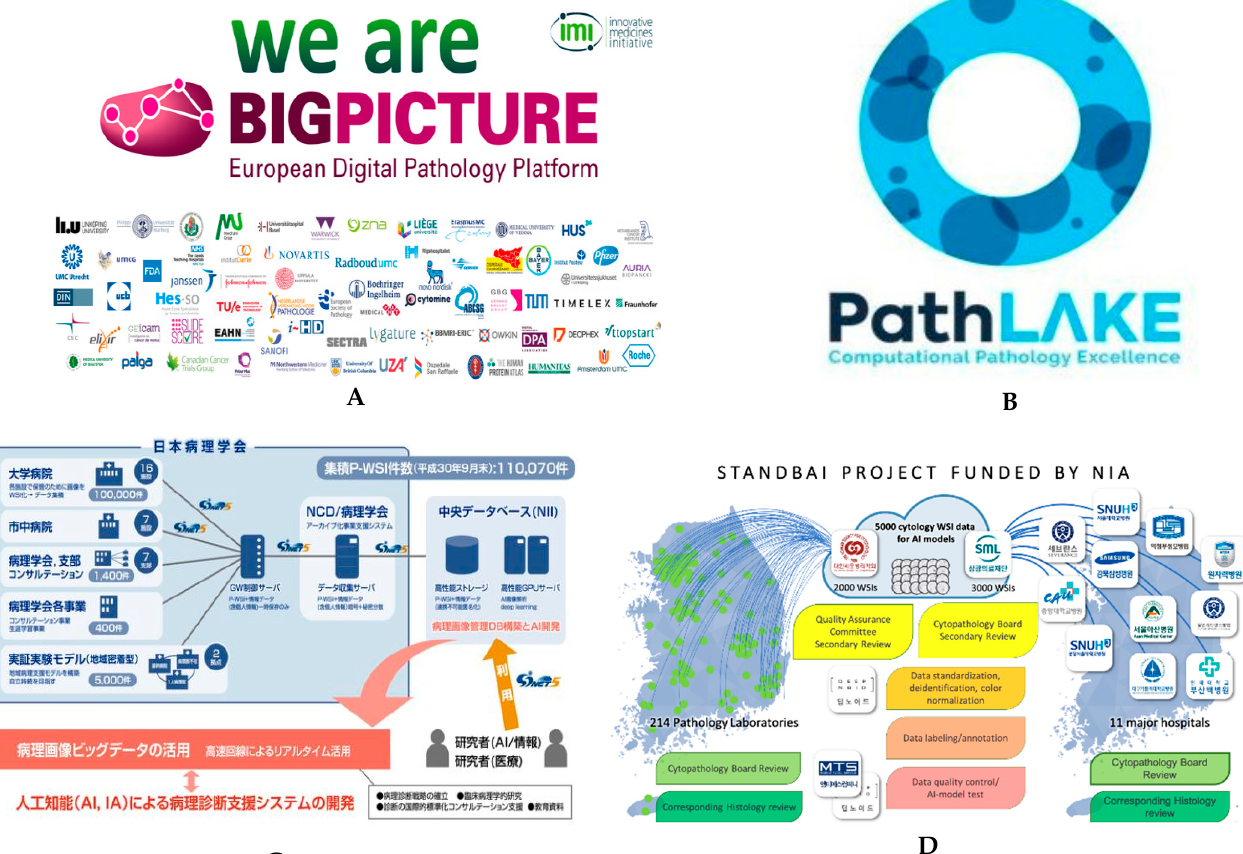
Figure 11. Representative figures of digital slides from repository projects: ( A ) BIG PICTURE, ( B ) Path LAKE, ( C ) JP-AID, and ( D ) NIA Data Dam.